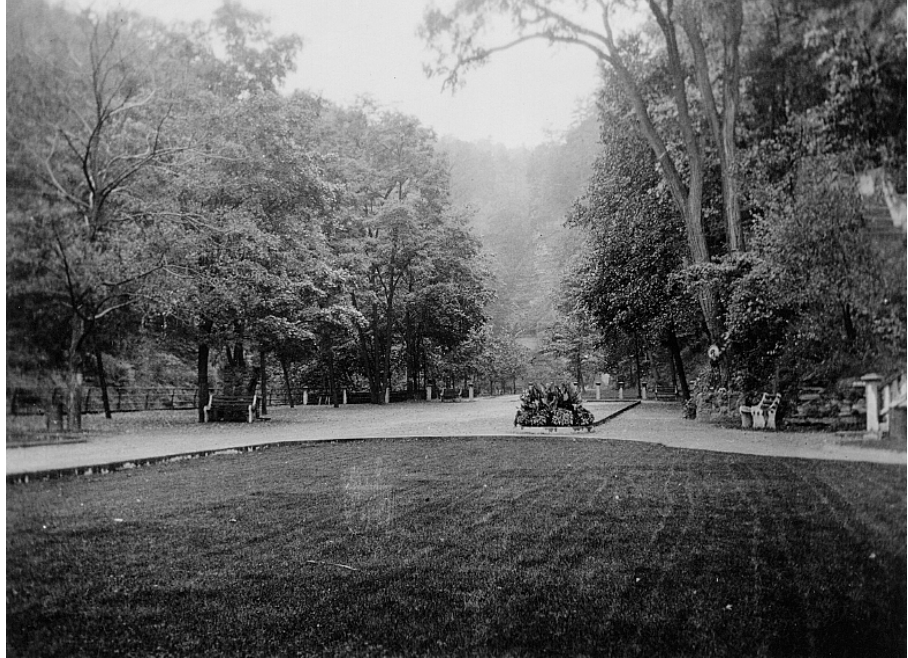
Figure 12. Entrance Lawn, ca. 1920; before the flood of 1935. Photo used with permission: NY State Office of Parks, Recreation & Historic Preservation; parks.ny.gov (accessed on 12 June